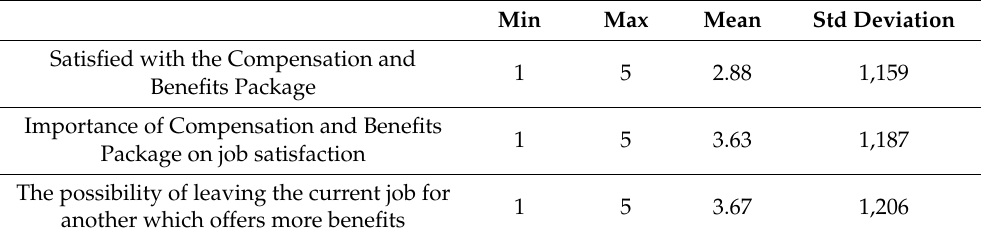
Table 6. SPSS output of mean and standard